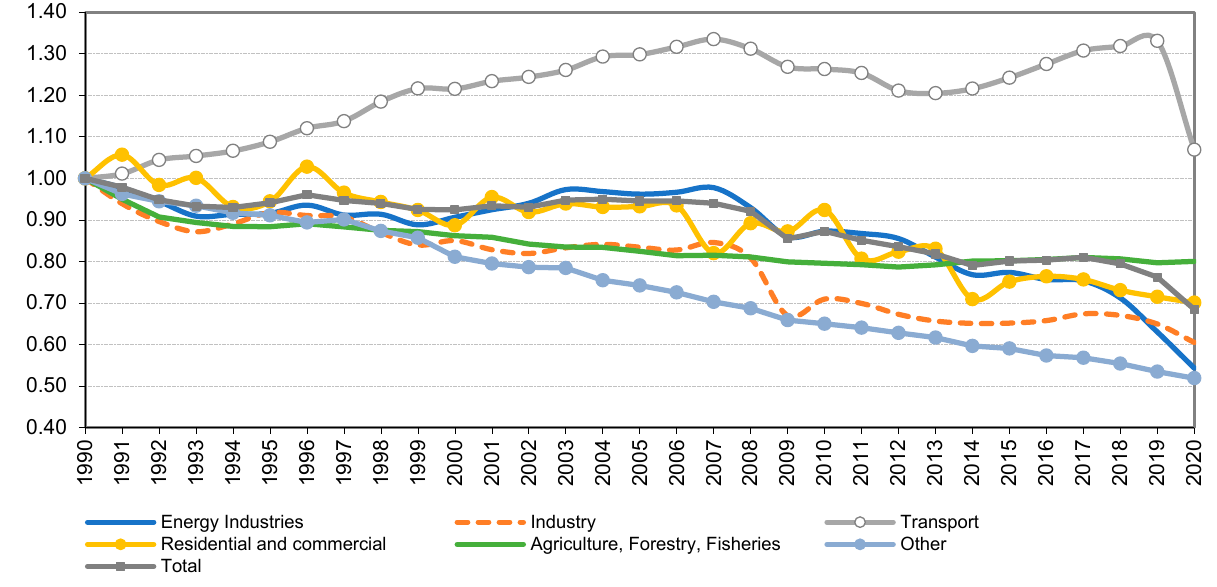
Figure 10. Greenhouse Gas Emissions by sector in the EU (1990 = 1). Source: Own elaboration based on European Environment Agency, 2022.